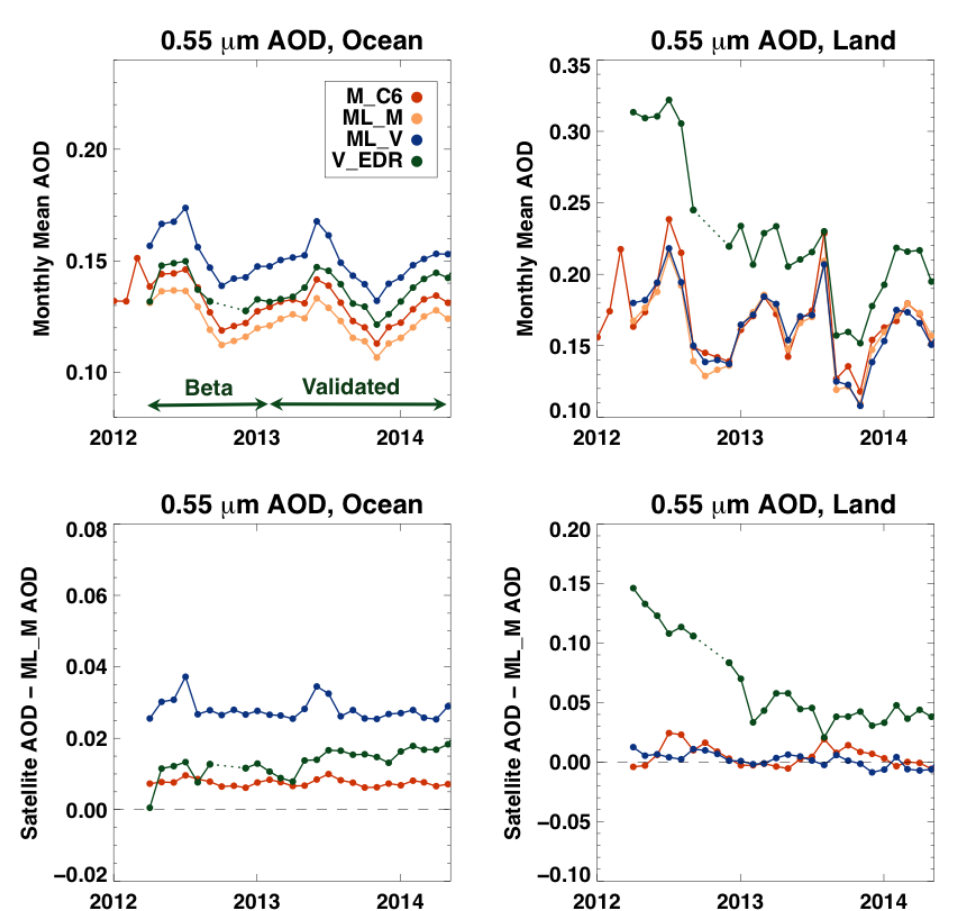
Figure 15. Time series of monthly mean, global AOD at 0.55µm, over ocean (left panels) and land (right panels). The top panels refer to the magnitude, the bottom plots are the differences as compared to the MODIS-like on MODIS. The “beta” and “validated” refers to the VIIRS EDR product, highlighting the relative convergence of VIIRS EDR for global mean, after February 2013. Note different y